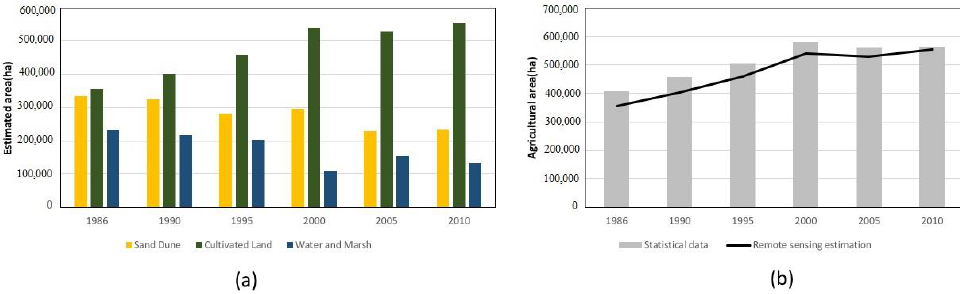
Figure 9. Image segmentation results of the Hetao Irrigation District in 1986–2010.